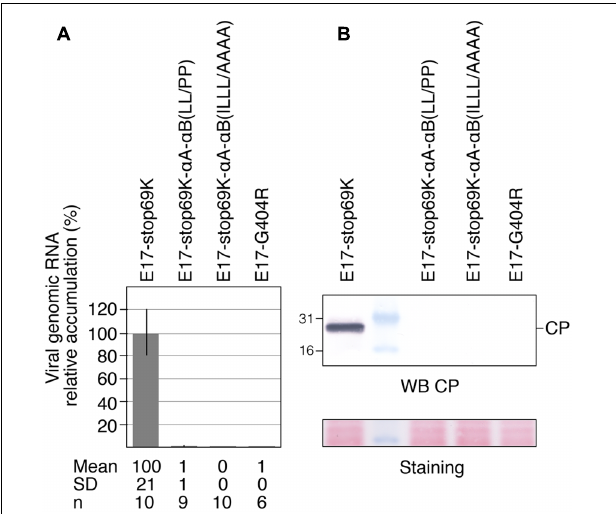
FIGURE 8 | Impact of the structure and amphipathic property of CTD α -helices on viral infectivity. Arabidopsis protoplasts were transfected with in vitro transcripts as indicated, and cells were harvested 48 hpt. (A) The ability of the transcripts to replicate was assessed by extracting total RNAs and quantifying viral genomic RNA by RTqPCR. The relative accumulation of viral mutant RNAs as compared to the E17-stop69K control is represented as the mean ± SD. Mean and SD values, as well as the number of samples (n) analyzed in two independent experiments are indicated below panel (A) . (B) The ability of the transcripts to replicate was assessed by subjecting total protein samples to 15% SDS-PAGE and immunoblot analysis using anti-CP antiserum. Molecular mass markers (Biolabs) are indicated on the left whereas position of CP is indicated on the right. Ponceau staining of the membrane (staining) indicates protein loading.